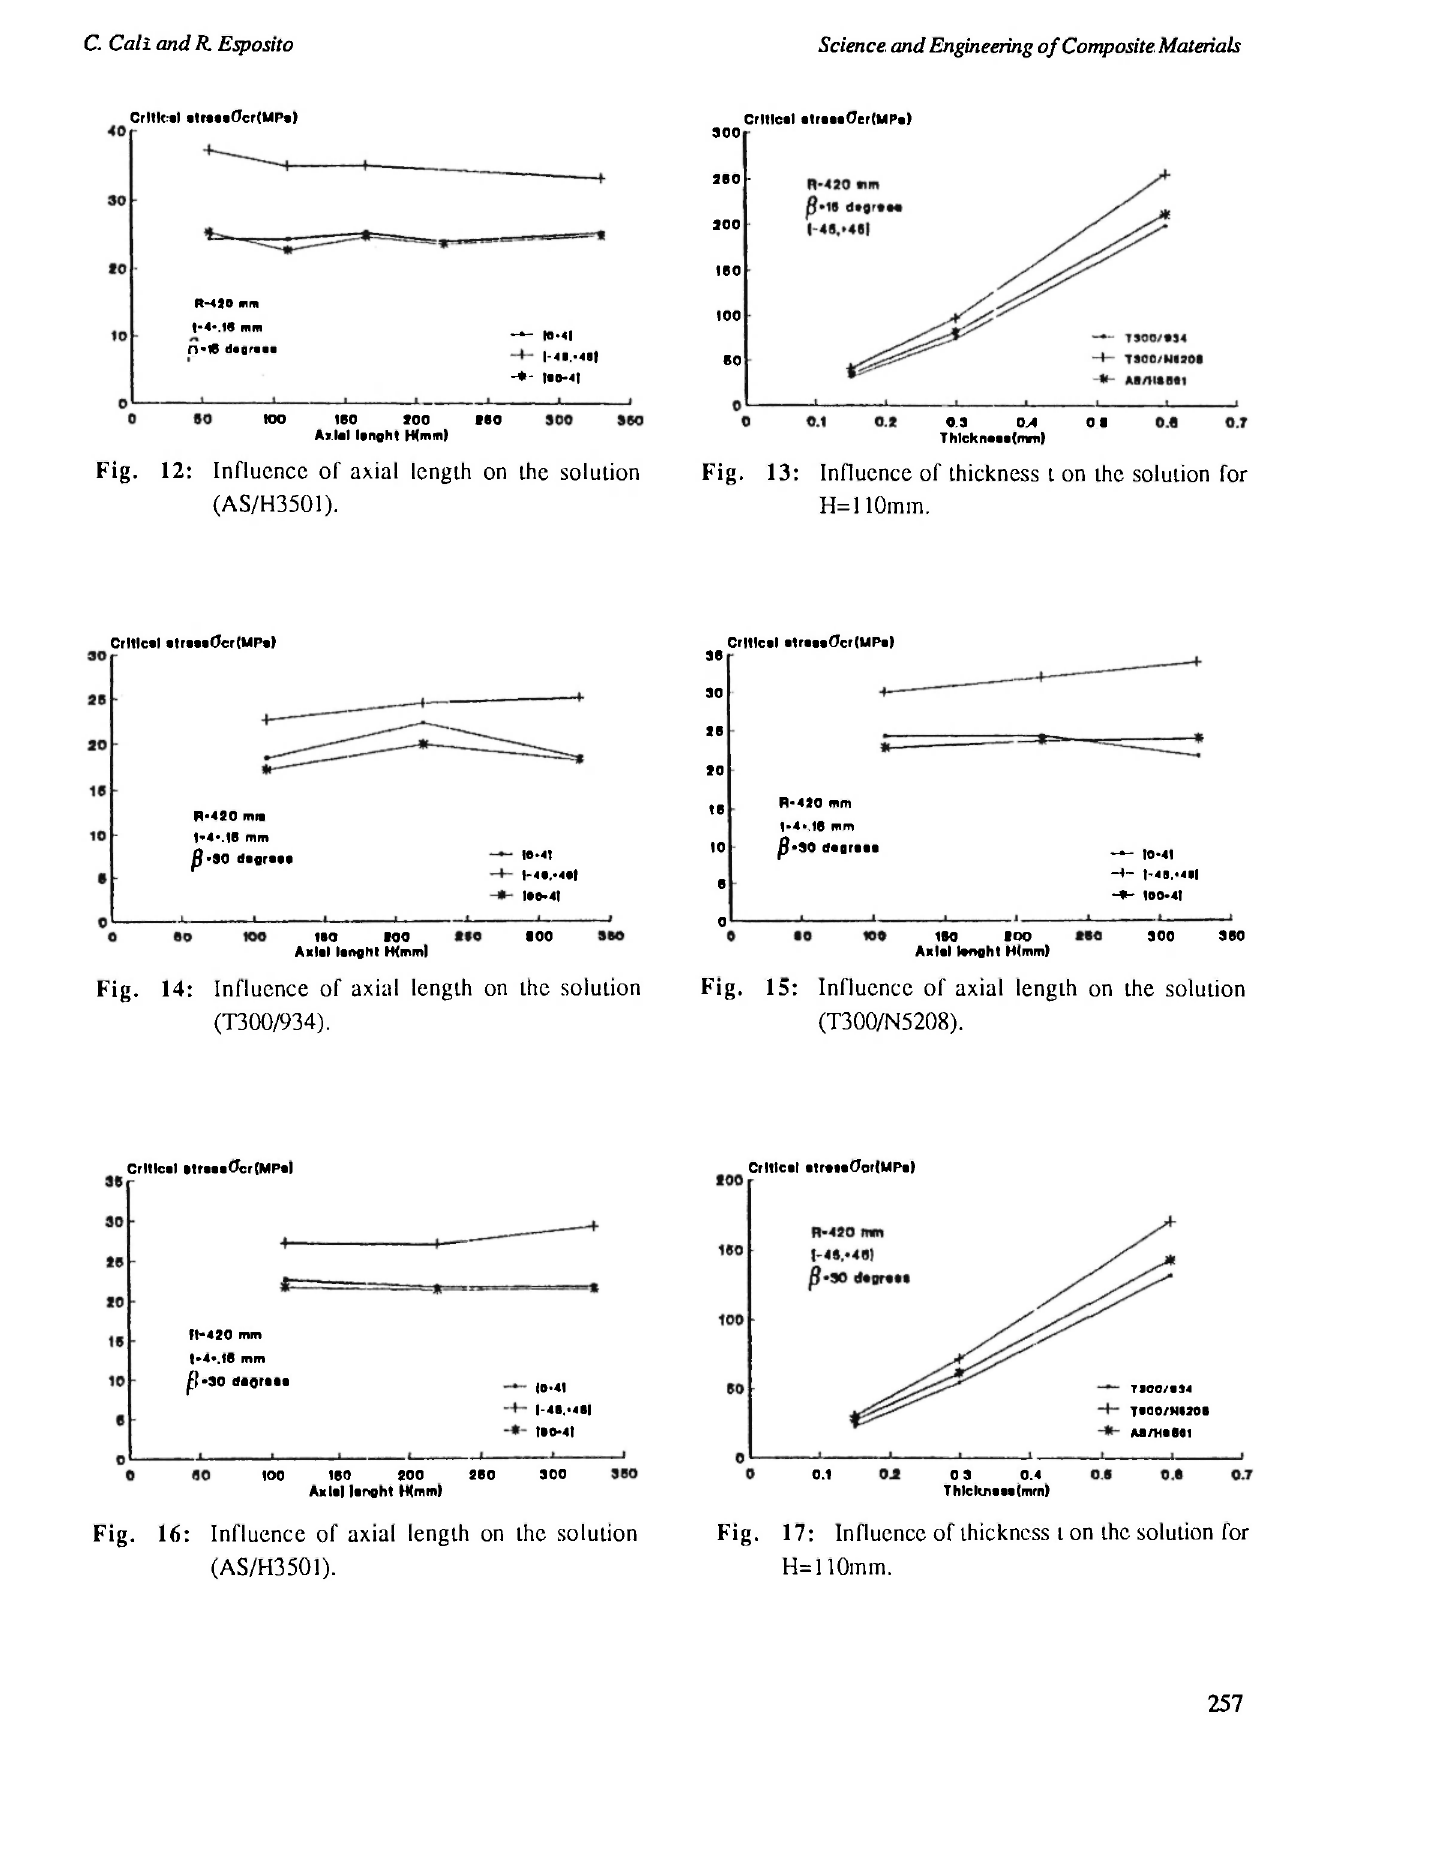
16: Influence of axial length on the solution (AS/H3501).